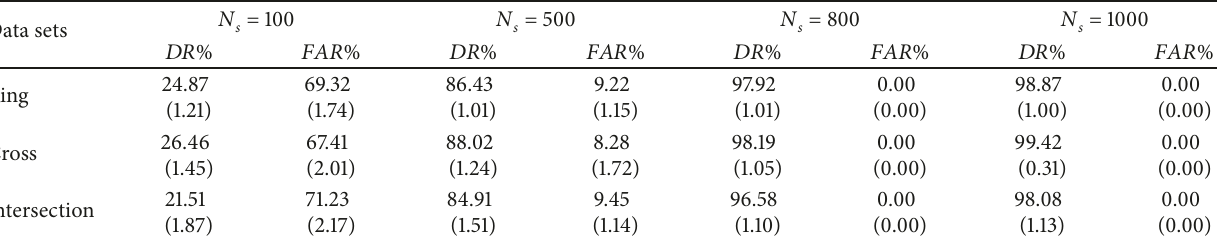
Table 3: Influence of different training set sizes on